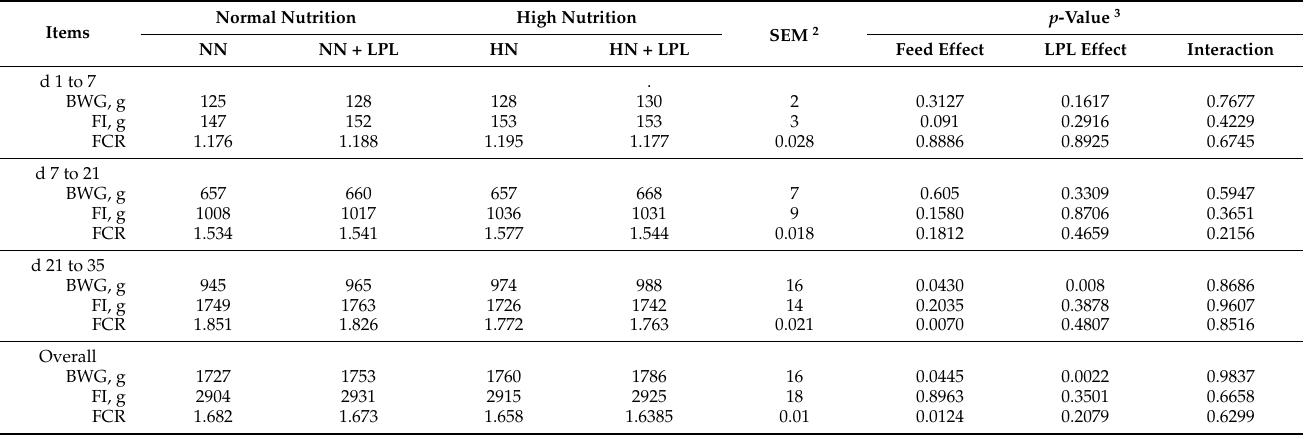
Table 3. Effect of LPL supplementation in diet with different nutrition content on growth performance in broilers 1 .